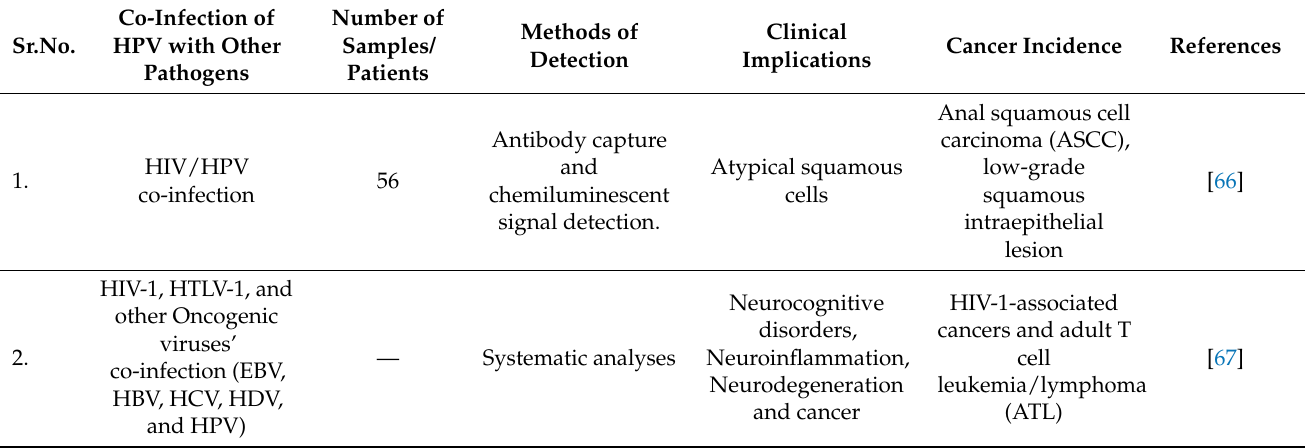
Table 1. A brief account of recent studies representing HPV-associated viral and pathogenic co- infections in different cancerous